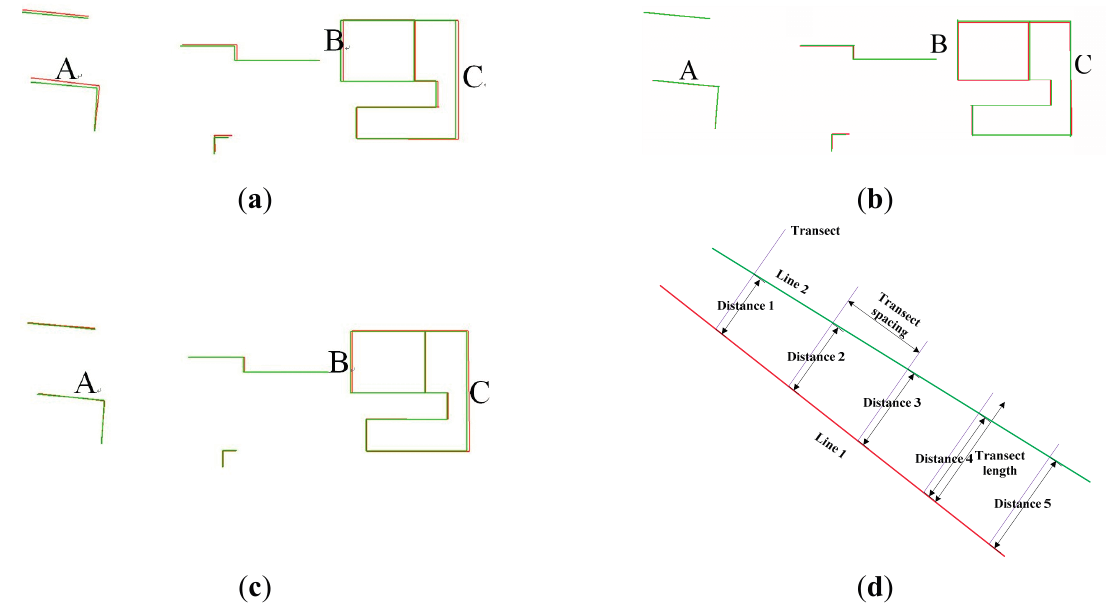
Figure 10. Geometric precision evaluation by using common building